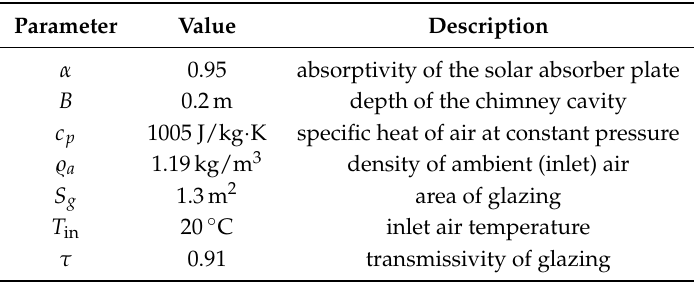
Figure 1. Schematic of the solar chimney ( left ) and the numerical discretization ( right ). Table 1. Parameters and inputs to the model of the solar